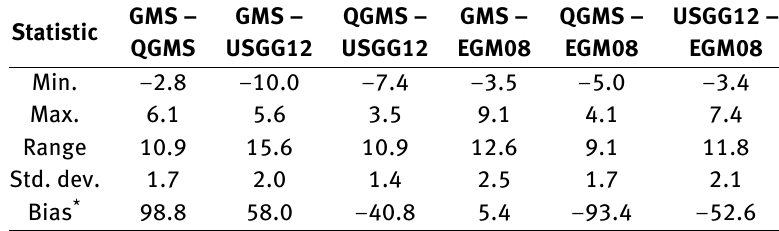
Table 2: Statistics of the differences between the different geoids for the Louisiana test area. Unit is in cm